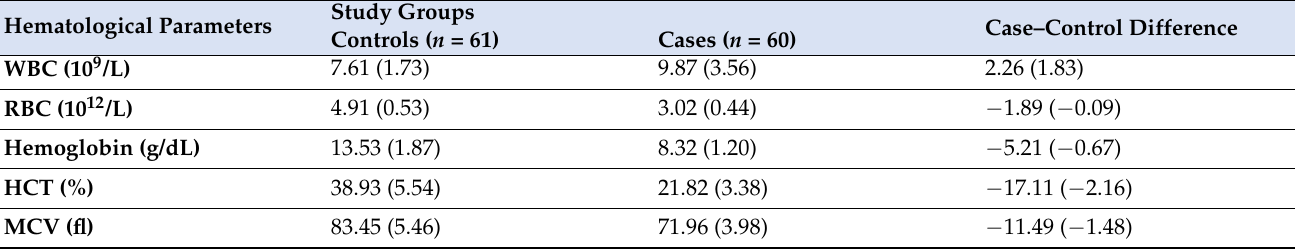
Table 1. Comparison of hematological parameters and iron study between patients with β -thalassemia major and their matched